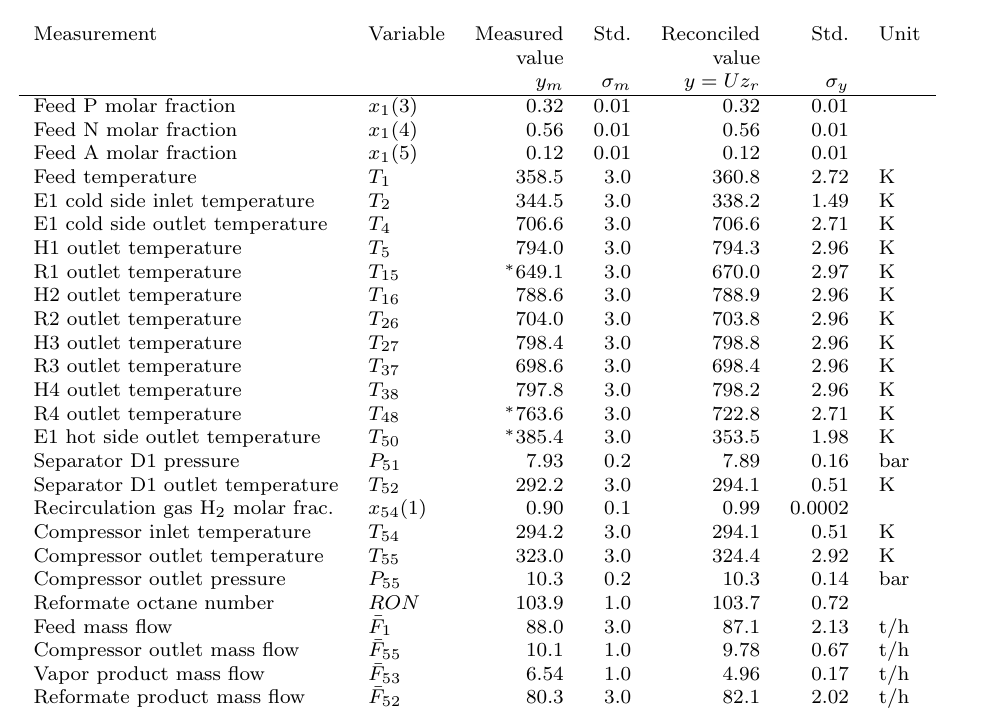
Table 5: Reconciled values of the measured variables for data set no. 12